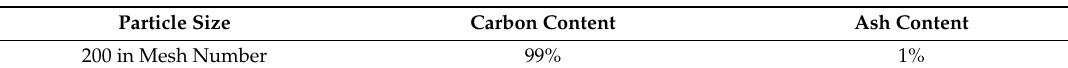
Table 2. Characteristics of the graphite.